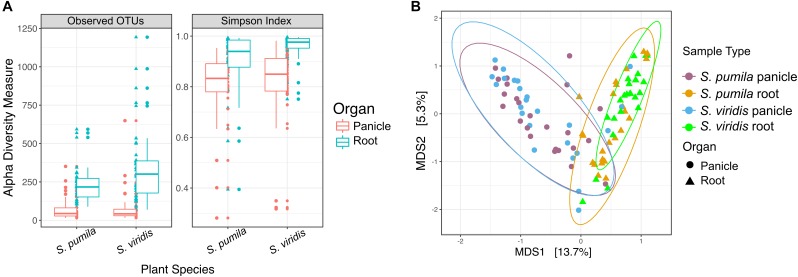
Bacterial endophytic diversity within roots and panicles of Setaria pumila and Setaria viridis
(A) α-diversity metrics for communities within roots and panicles of Setaria spp. Significant (p < 0.001) higher richness was observed in root tissues when compared to panicle communities. Evenness (Simpson-index), was also significantly different between plant organs. (B) Principal coordinate analysis (PCoA) of S. pumila and S. viridis samples that were collected simultaneously from the same locations revealed the plant organ as the main driver of endophyte communities (separation across the first PC).